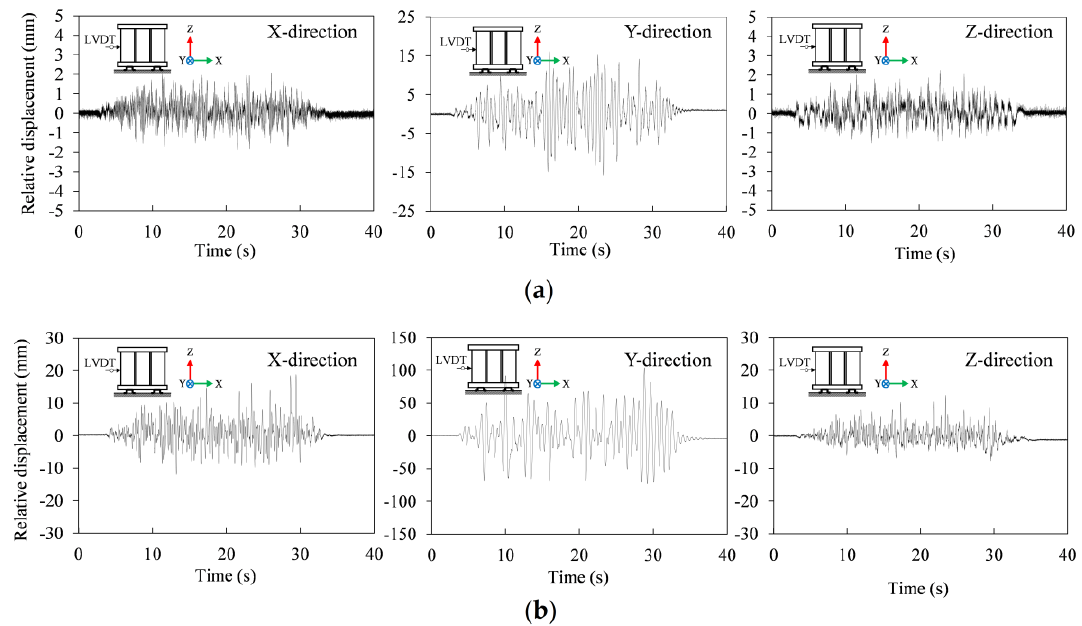
Figure 16. Relative displacement response-time histories of test specimen at the left coil. ( a ) at AC156_75; ( b ) at AC156_300.